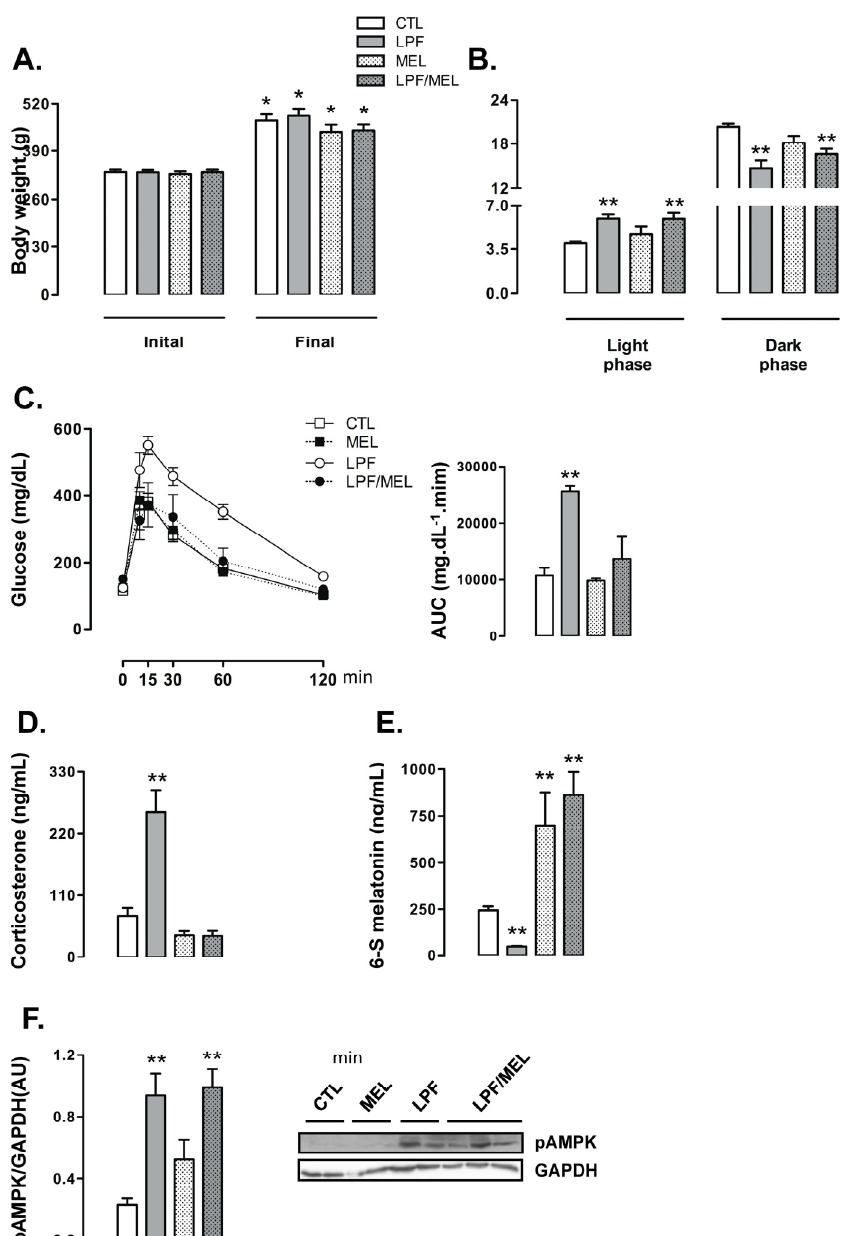
Figure 5. Nocturnal melatonin administration in rats exposed to fructose during the light phase. Rats were assigned to the groups control (CTL), Light Phase Fructose (LPF), melatonin (Mel) and Light Phase Fructose with melatonin (LPF/Mel). ( A ) Body weights were assessed before and after (eight week) treatments; ( B ) Food intake during the light and the dark phases were also assessed at the end of the treatments; After these measurements ( C ), the rats were subjected to glucose tolerance tests. Tests were performed two hours before “lights off” and area under the curve (AUC) was calculated. Euthanasia was performed two hours before “lights off” and the hypothalamus and plasma were collected; ( D ) Plasma samples were used for the determination of corticosterone levels; ( E ) Urine was collected overnight before euthanasia for determination of 6 ‐ S ‐ Mel concentration; ( F ) Hypothalamus samples were used for Western blot detection of phosphorylated adenosine monophosphate ‐ activated protein kinase and normalization by Glyceraldehyde 3 ‐ phosphate dehydrogenase (GAPDH). The results are presented as the means ± standard error of the mean. * p < 0.05 vs. same group before treatment; ** p < 0.05 vs. CTL at the same phase of the light/dark cycle.